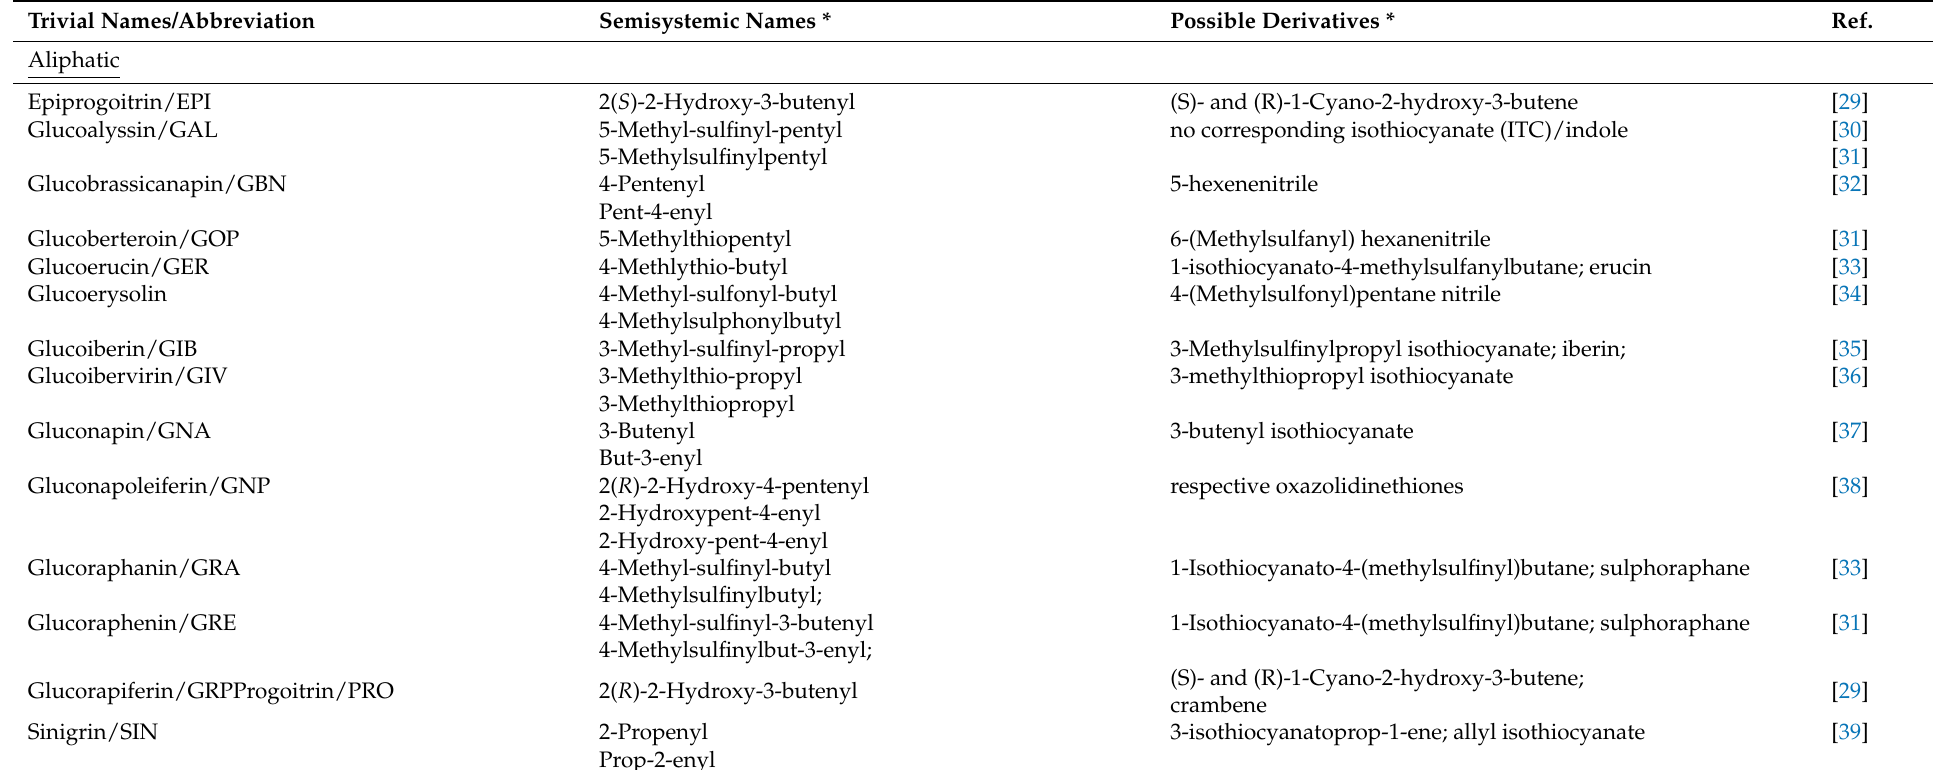
Table 1. Glucosinolates and examples of their possible